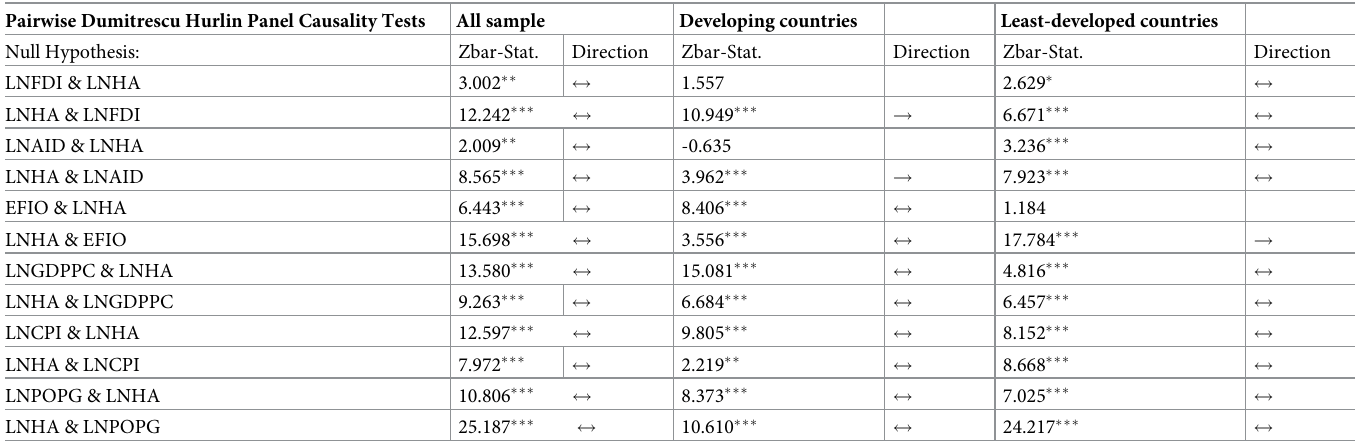
Table 7. Pairwise Dumitrescu Hurlin panel causality tests. Pairwise Dumitrescu Hurlin Panel Causality Tests All